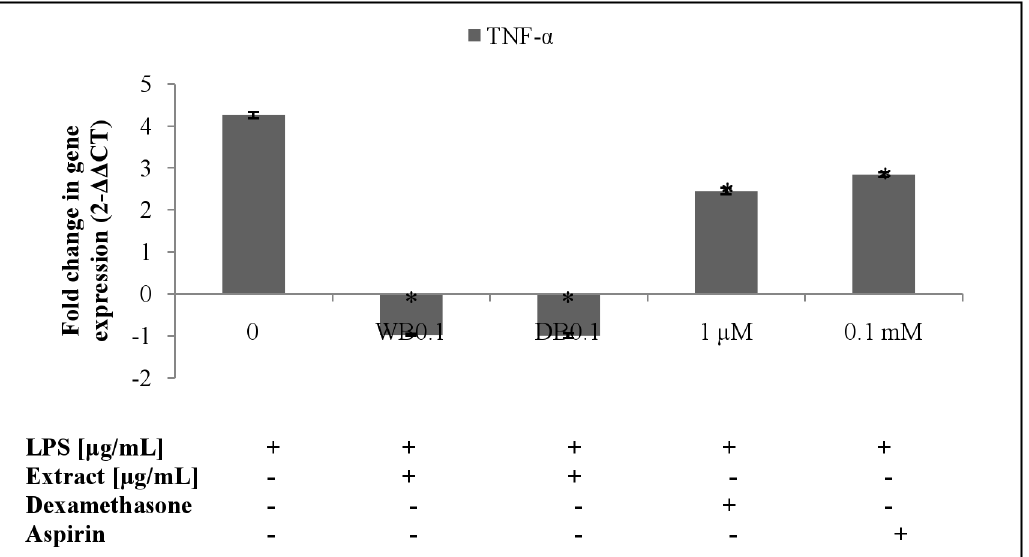
Fig 8. Effects of A . rugosum extracts on TNF- α gene expression (S1 Dataset). RAW264.7 cells were co-incubated with A . rugosum extracts (WB0.1: 0.1 μ g/mL WB; DB0.1: 0.1 μ g/mL DB) and 1 μ g/mL LPS for 24 hrs. Dexamethasone (1 μ M) and aspirin (0.1 mM) served as positive controls. β -actin was used as loading control and normalised against the treated group. Results shown represent the mean ± SD, n = 3 and * p < 0.05 versus LPS-induced NO level alone.